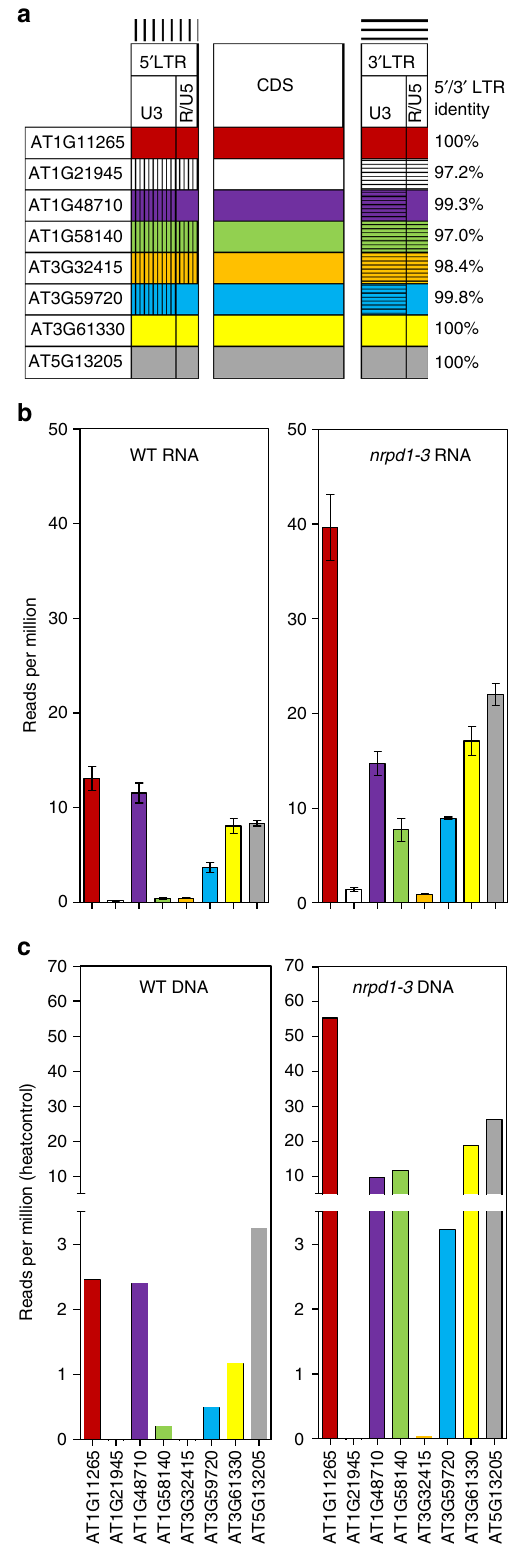
Fig. 1 Heat stress activation of individual Onsen members at both the transcript and ecDNA levels. a Colour key for each Onsen member; retrotransposon domains such as LTRs (with U3 and R/U5 regions) and central coding-sequences (CDS) are depicted. Percent identities of 5 ′ /3 ′ LTRs of each member are displayed at the right. In those older members in which 5 ′ and 3 ′ LTRs differ, vertical (5 ′ ) and horizontal (3 ′ ) lines depict distinct sequences for different LTRs. Old members AT1G48710/ “ violet ” and AT1G58140/ “ green ” display complete central CDS. b Heat-induced transcript levels for each individual Onsen member derived from RNA-seq analysis of wild-type and nrpd1-3 plants subjected to heat stress. Data represent means ± SEM for n = 2 independent biological replicates. c Heat- induced ecDNA abundance for each individual Onsen member, as inferred from whole-genome sequencing of wild-type and nrpd1-3 plants under control growth or subjected to heat stress. The bars represent subtraction of the control counts from the heat sample counts. In both b , c , NGS reads mapping to the Onsen family were assigned to individual members using unambiguous sequences matching each individual member in independent areas (further details in the text) and then counted, normalised to mapped library size, and averaged. Colour code as in Fig.